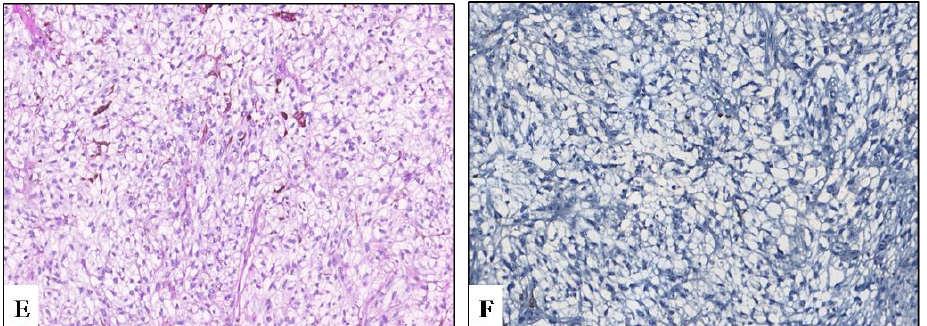
Figure 2. ( A ) Low magnification showing an ovoidal-shaped, poorly-pigmented choroidal tumor of the posterior ocular chamber (hematoxylin and eosin; original magnification 25 × ). ( B ) Due to the mass effect, the lesion induces a massive retinal detachment (hematoxylin and eosin; original magnification 50 × ). ( C ) Tumor exhibits a diffuse ballooning morphology, consisting of medium-sized, ovoidal cells with abundantly to weakly clear eosinophilic granular cytoplasm; few pigmented melanophages are also seen (hematoxylin and eosin; original magnification 400 × ). ( D ) A small portion of the neoplasm is composed of more pigmented spindle-shaped cells with elongated nuclei and conspicuous nucleoli (hematoxylin and eosin; original magnification 150 × ). Neoplastic cells are consistently negative for PAS ( E ) and BAP-1 ( F ) immunostaining. ( E ), periodic acid–Schiff staining;